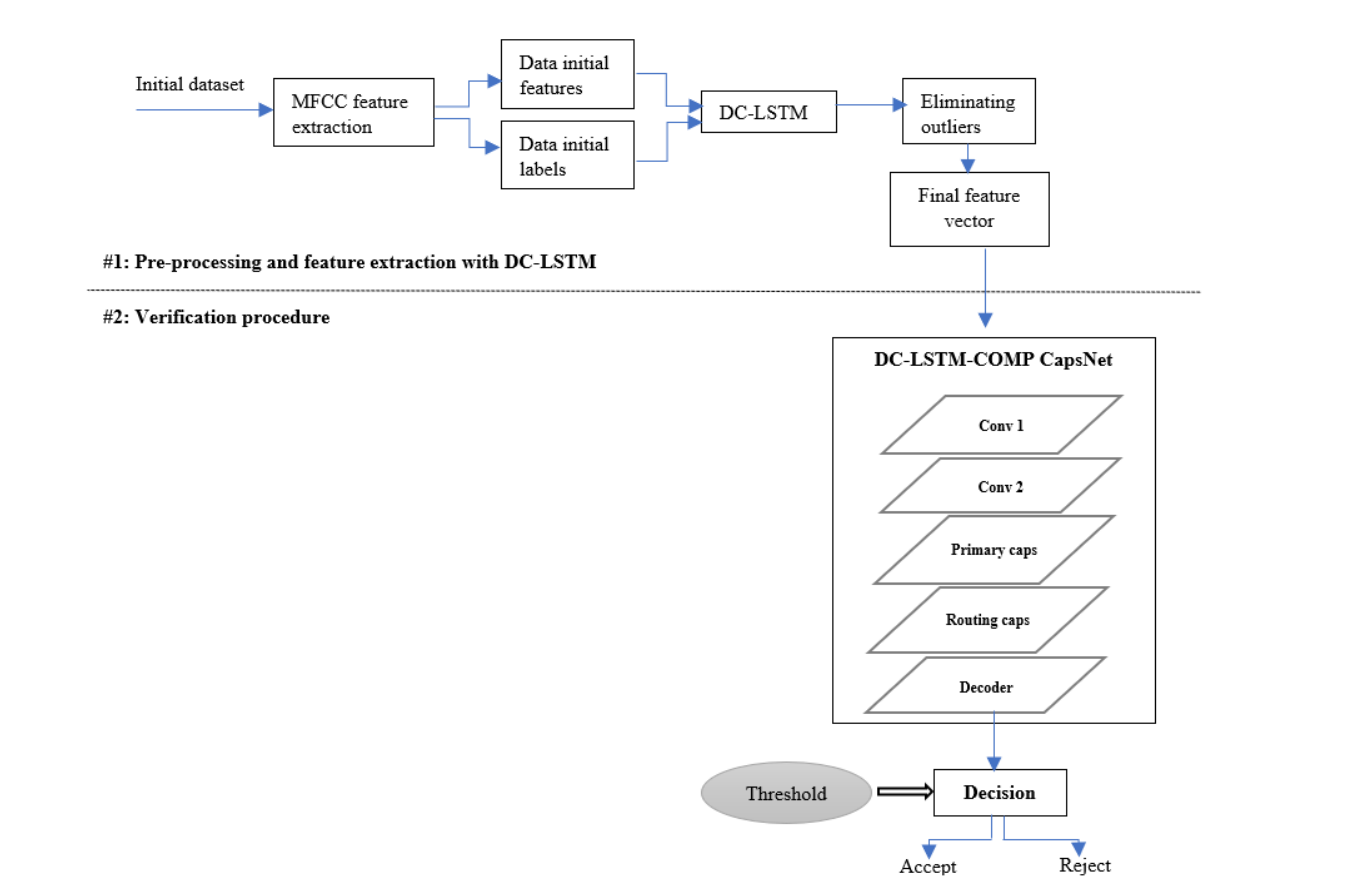
Figure 2. The overall architecture of speaker verification using the proposed modified CapsNet model.